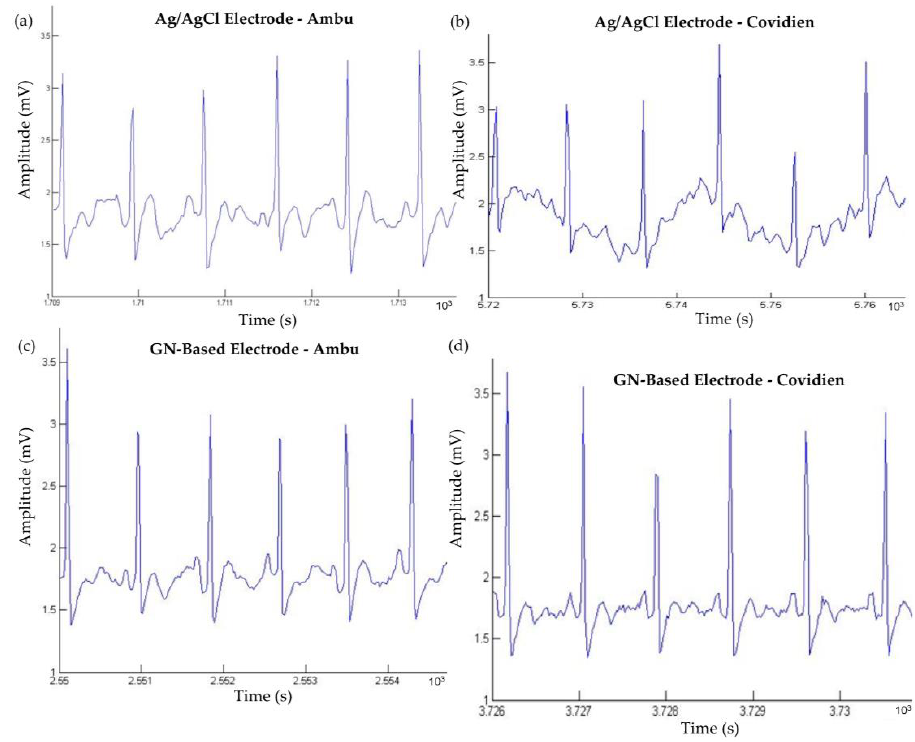
Figure 10. Ear-lead based ECG signals from the Ag/AgCl electrode and from the GN-based electrode using Ambu (larger size) and Covidien (smaller size) types of electrodes ( a – d ).